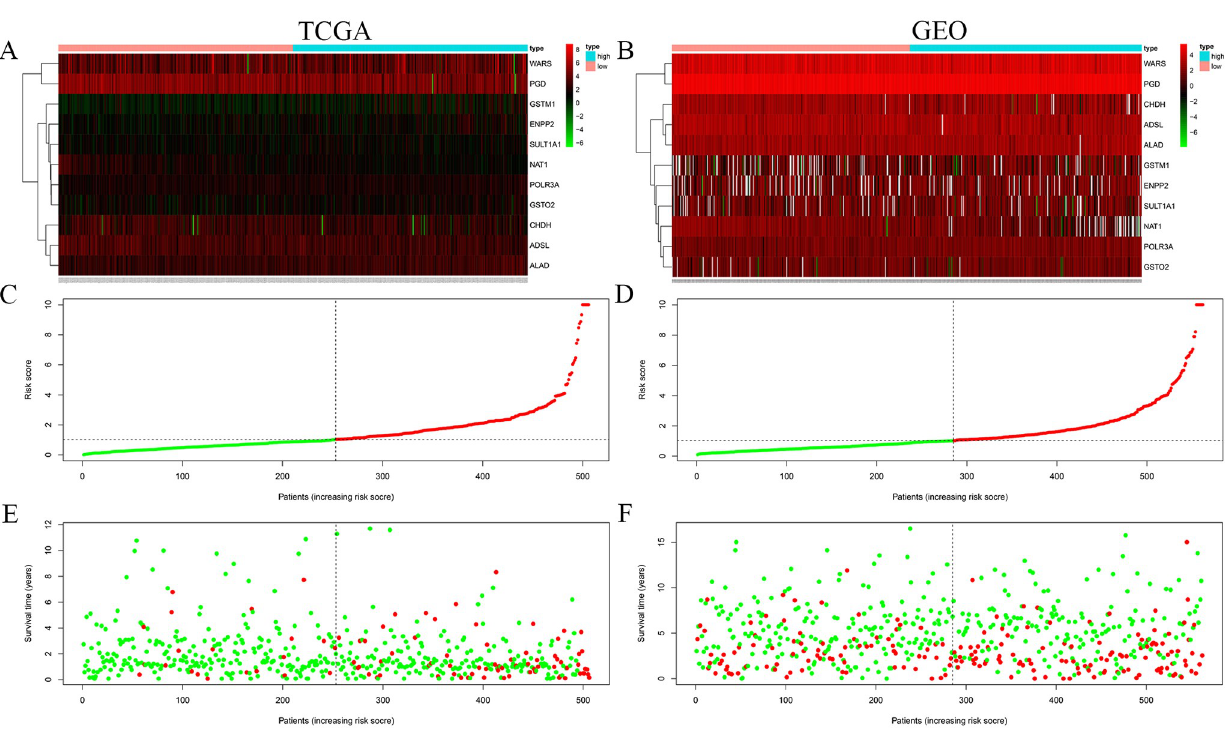
Fig 2. Risk heat map, risk curve and survival status diagram of risk score. The risk heat maps (A, B) show that 9 genes are highly expressed in the high- risk group and 4 genes are highly expressed in the low-risk group. The risk curves (C, D) show that the model risk score is positively correlated with the risk value of CRC patients. The survival status diagram (E, F) shows that people with higher risk values have a worse prognosis. A, C, and E are the analysis of the TCGA-CRC cohort, while B, D, and F are the analysis of the GSE39582 cohort.